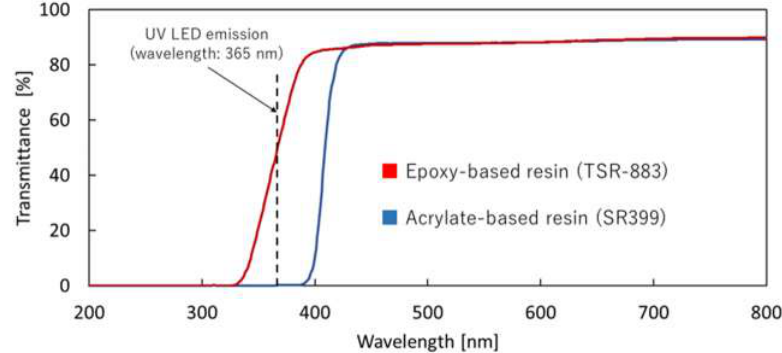
Figure 3. Transmission spectra of two cured resins: a commercial epoxy-based resin (TSR-883) and a laboratory-made acrylate-based resin containing SR399.